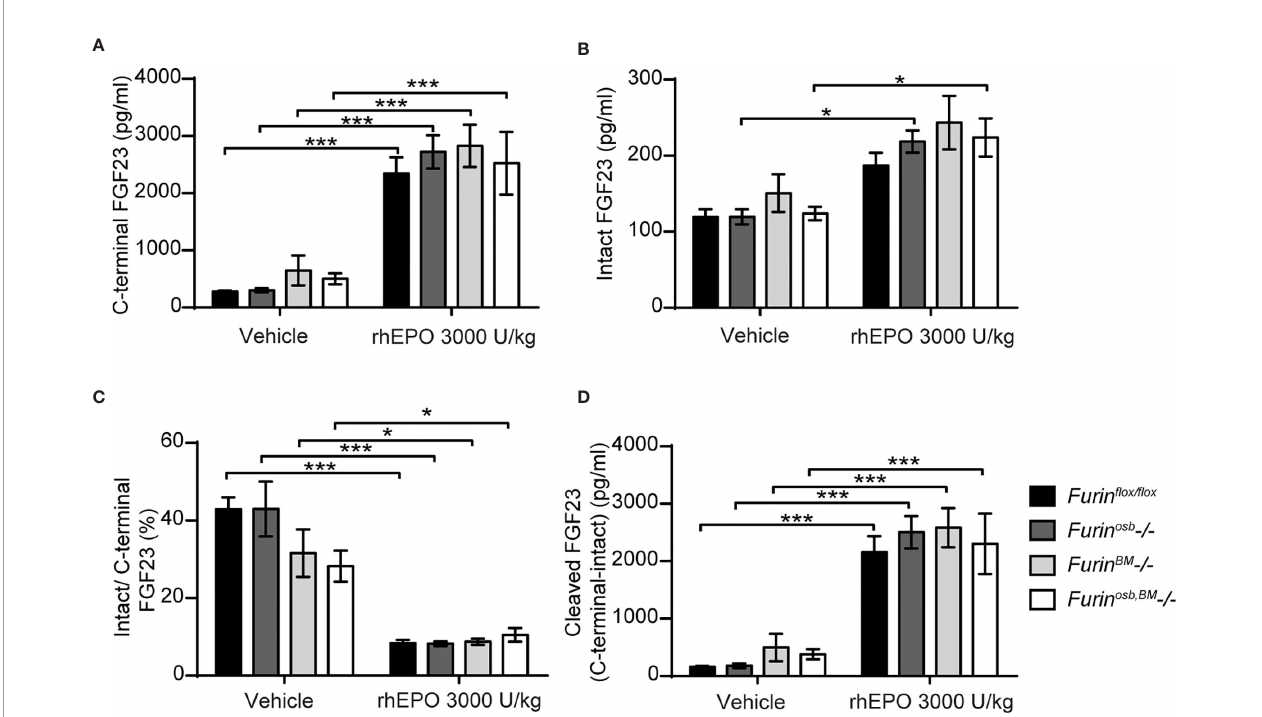
FIGURE 4 | Furin inactivation in osteoblasts, osteocytes and hematopoietic cells did not impair FGF23 processing following erythropoietin injection. Plasma FGF23 measurements in 8-week-old Furin fl ox/ fl ox (n=7), Furin osb -/- (n=5), Furin osb -/- (n=5) and Furin osb;BM -/- (n=6) male and female mice 6 hours following injection of vehicle or 3000 U/kg of recombinant human erythropoietin (rhEPO): C-terminal FGF23 (A) , intact FGF23 (B) , percentage (%) of intact over C-terminal FGF23 (C) and cleaved FGF23 levels (D) , calculated as (C-terminal FGF23) - (intact FGF23). Results represent the mean ± SEM. * P < 0.05 and *** P < 0.001, by 2-way ANOVA with Bonferroni ’ s multiple comparisons test.